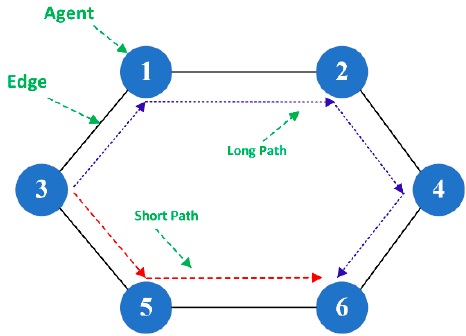
Figure 2. An example of a connected graph.